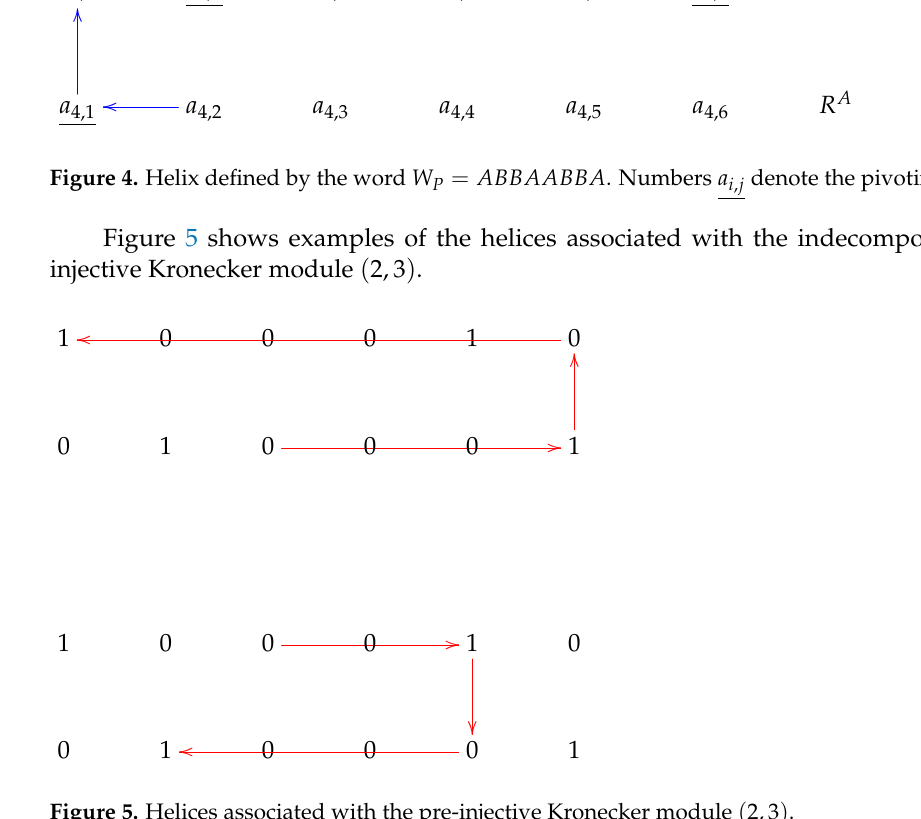
Figure 5. Helices associated with the pre-injective Kronecker module ( 2,3 )